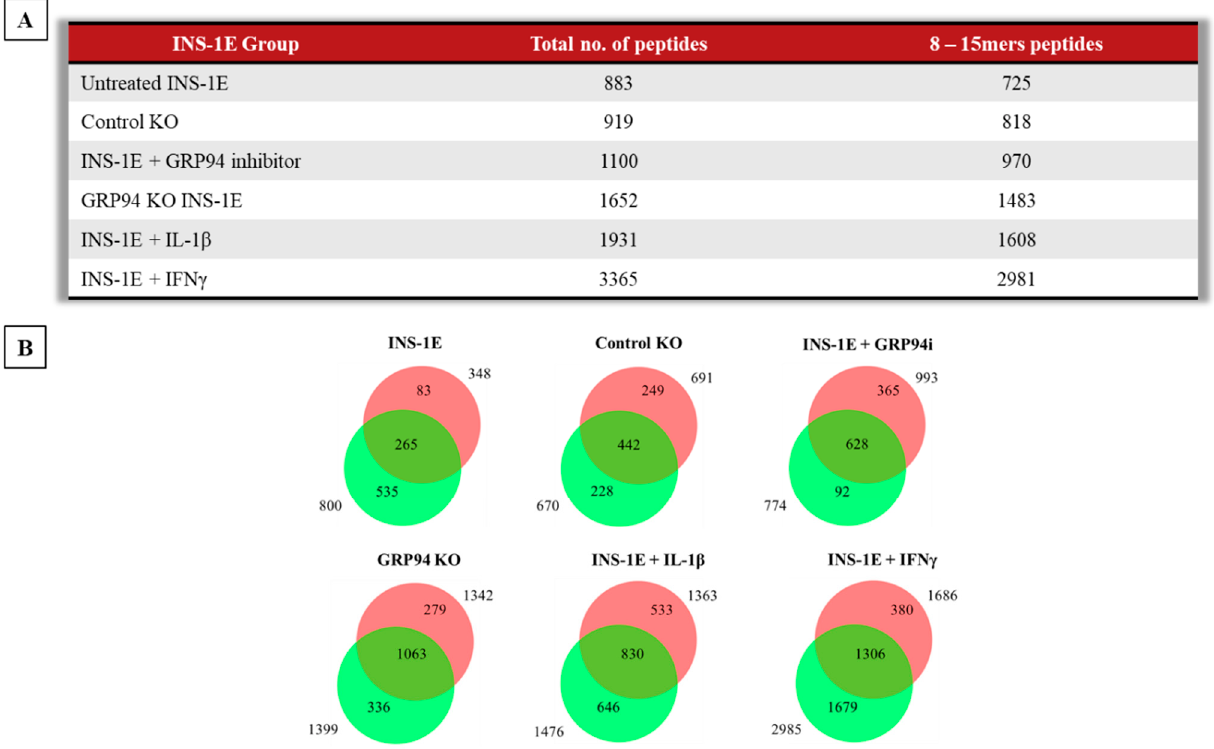
Figure 2. ( A ) Summary table of RT1.A-bound 8–15 amino acids length peptides from INS-1E cells under tested conditions. ( B ) Venn diagrams showing peptides overlap between the individual replicates per condition. n = 2 for all groups except for GRP94 KO where n = 4.